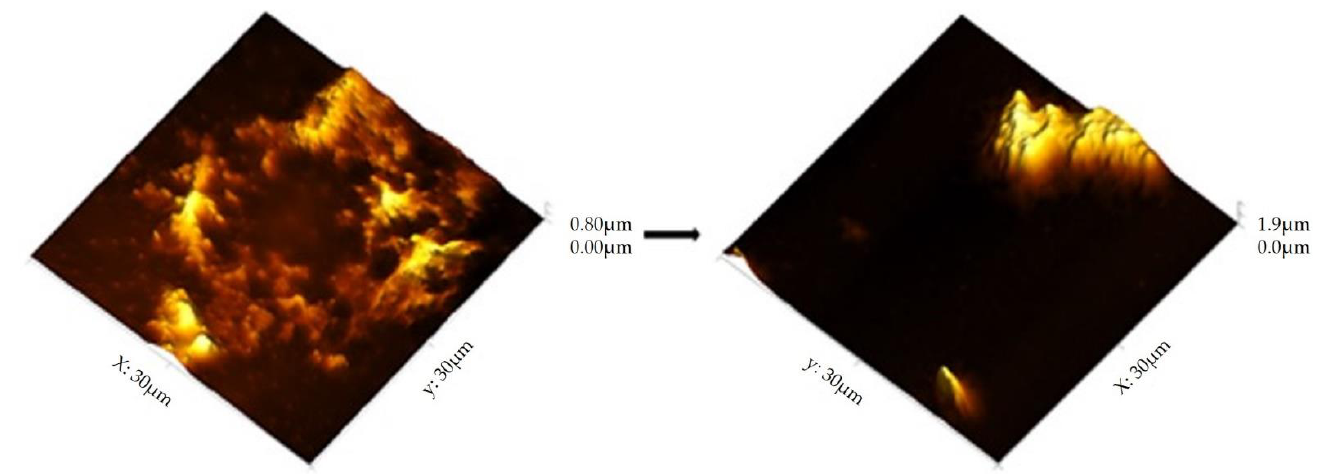
Figure 3. AFM images of sub-MIC concentrations of M. linifera extracts inhibiting biofilm formation by S. aureus . (Left) control — untreated; (right) treated with EE.